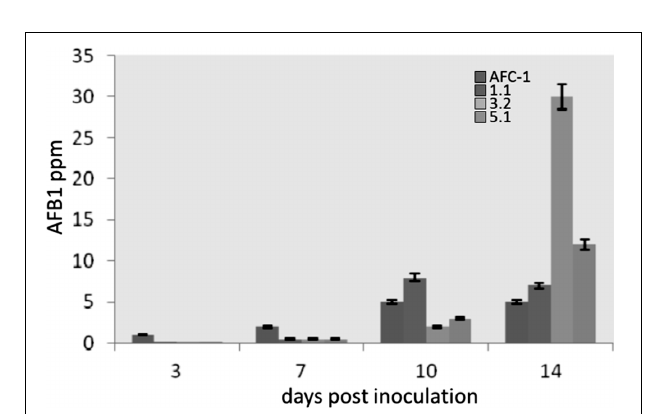
FIGURE 6 | Aflatoxin (AFB1) production measured by HPLC in culture filtrate (ppb), in the AFC-1 and Af lox1 (cid:2) strains grown in PDB at different time intervals of incubation (0–14dpi) at 30 ◦ C. Results are the mean ( ± SE) of a total of six replications deriving from two independent experiments.